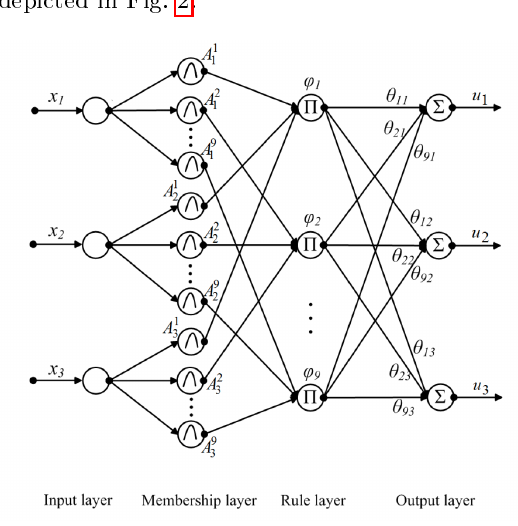
Fig. 2: Structure of the designed fuzzy neural network. This network structure has four layers: input layer, membership layer, rule layer and output layer. Nodes in the input layer are 3 state vari- ables of the slave chaotic JJ and their values are directly transmitted to the membership layer. sign, the membership layer has 3 × 9 nodes. Each node performs a membership function and em- ploys a Gaussian function to calculate its